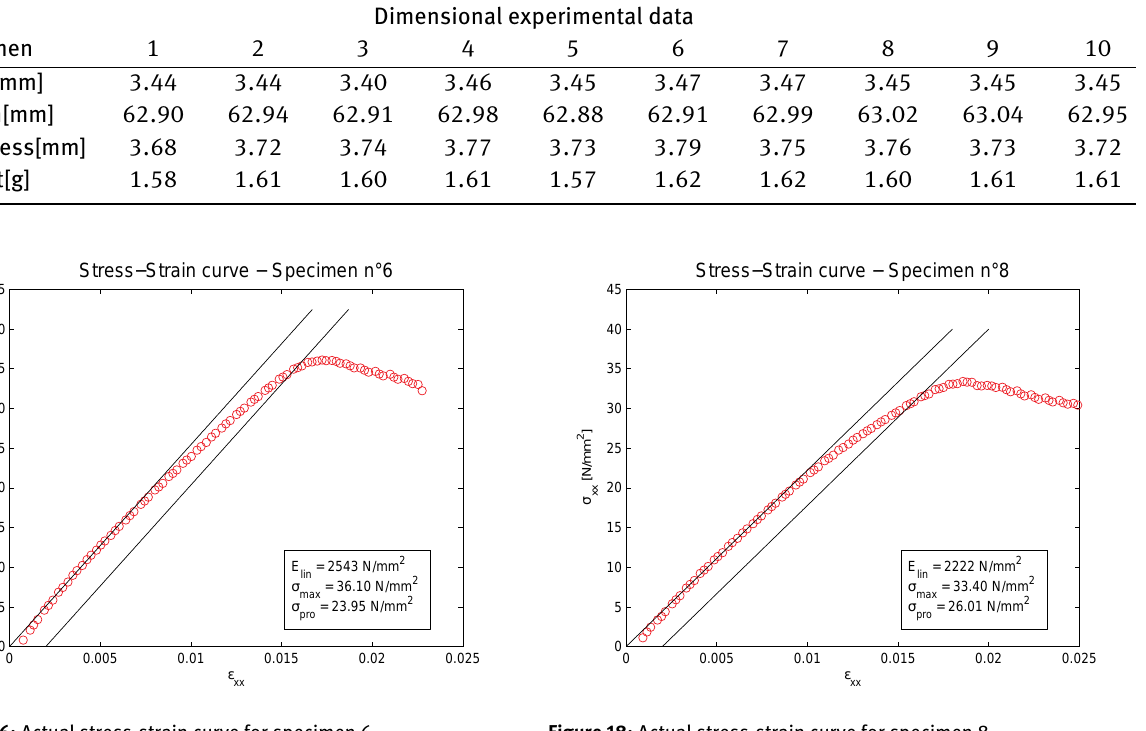
Figure 16: Actual stress-strain curve for specimen 6.